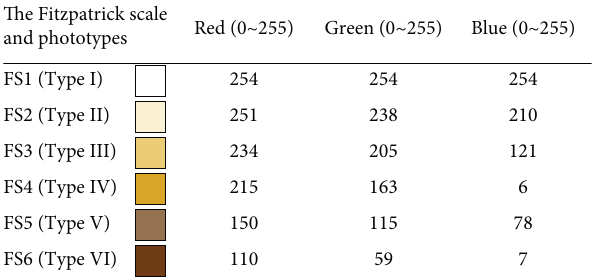
Table 1: RGB values of the Fitzpatrick scale